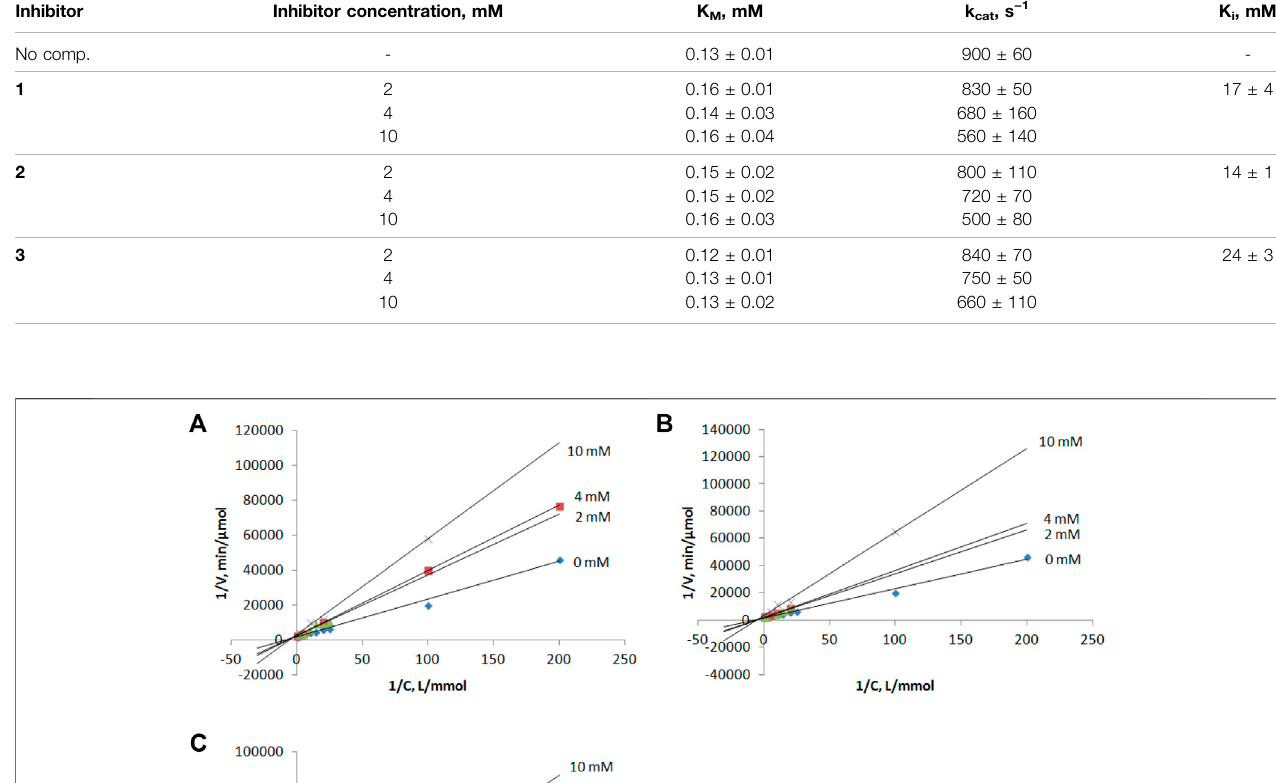
Frontiers in Chemistry |